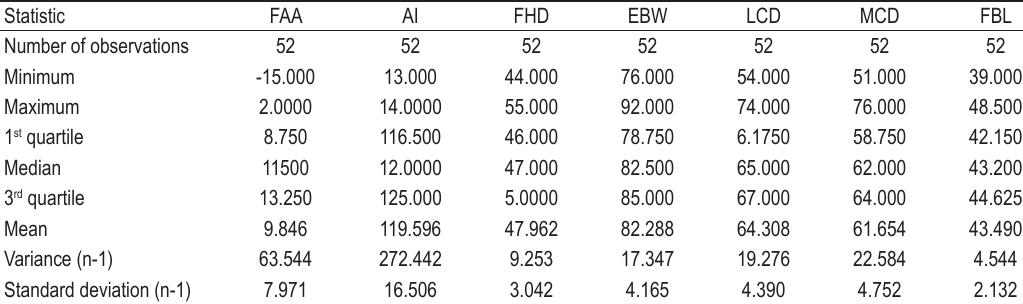
TABLE 1. Descriptive statistics for male